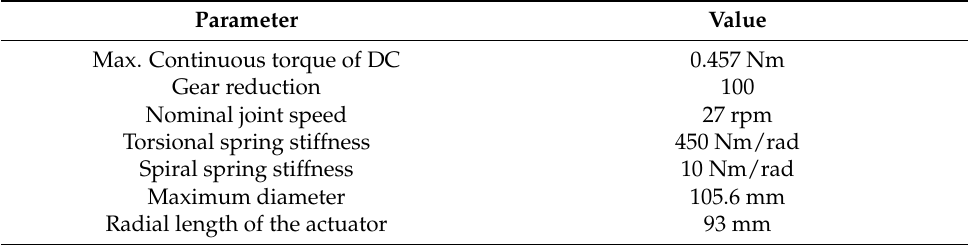
Table 2. Main features of the ES ‐ RSEA.